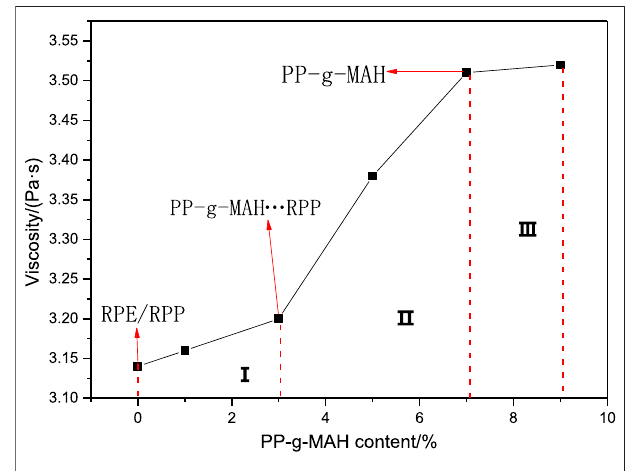
FIGURE 8 | Effect of PP-g-MAH content on the viscosity of modi fi ed